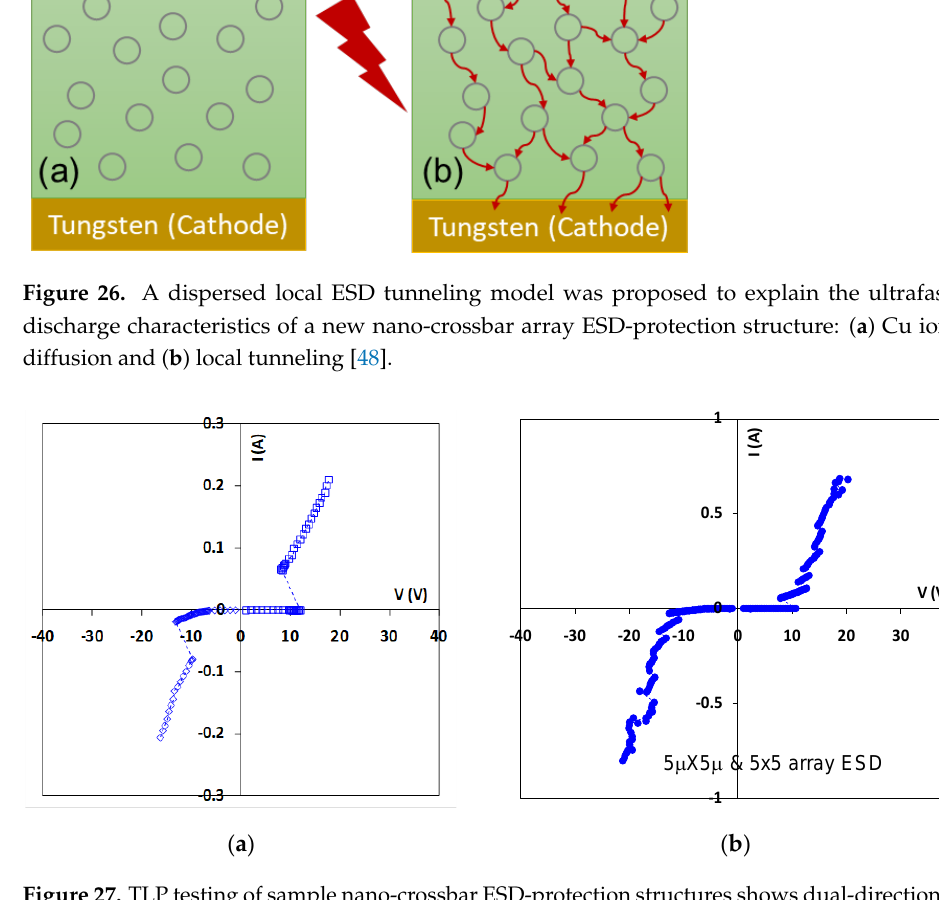
Figure 28. Measured ESD triggering voltages for sample ESD devices show V t1 tunability by design [49]. 0.0 0.4 0.81.21.6 0.0 V (V) Figure 29. Measured leakage currents for nano-crossbar ESD devices show extremely low ESD-induced I leak [49].